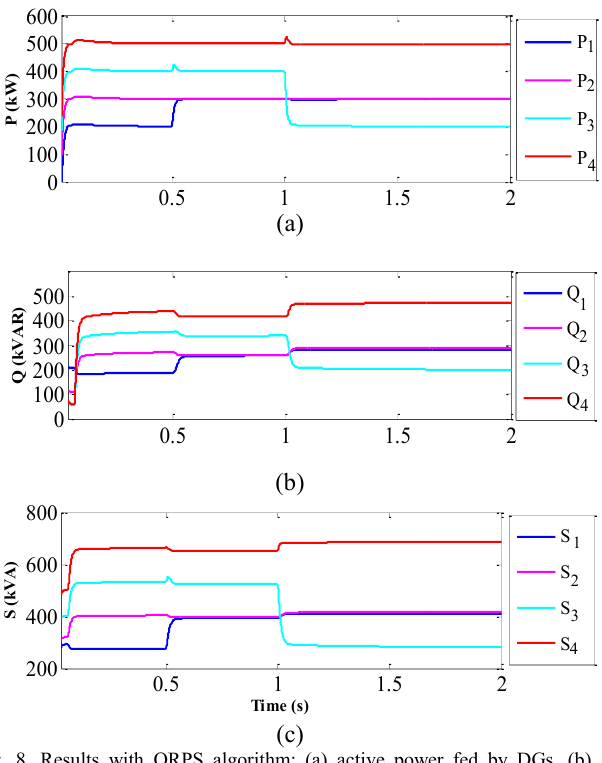
Fig. 8. Results with ORPS algorithm: (a) active power fed by DGs, (b) reactive power shared by the inverters, (c) apparent power of each